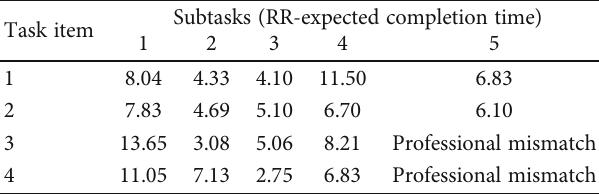
Table 19: RR-expected completion time. Task item